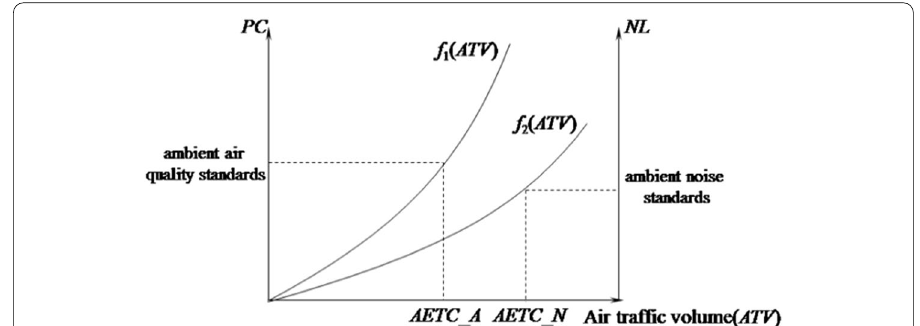
Fig. 1 Relationship between air traffic volume and